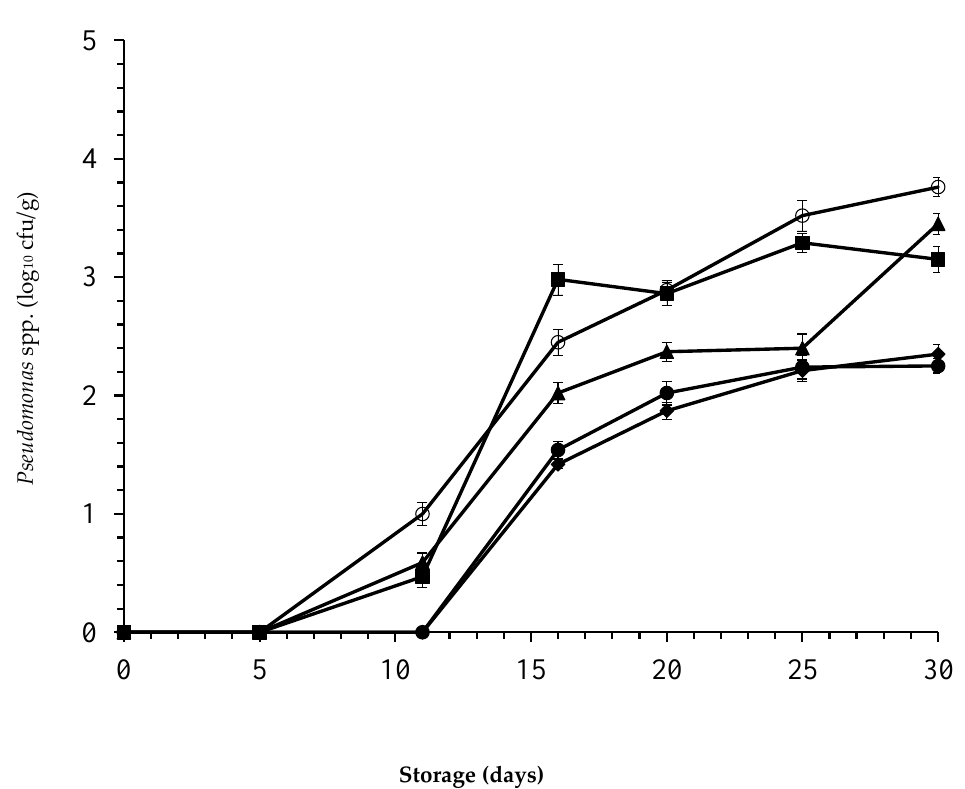
Figure 5. Numbers (log 10 cfu / g) of Pseudomonas spp. recovered from camel steaks stored at 1 ± 1 ◦ C under atmospheres of 80% O 2 and 20% CO 2 after treatment with 25 ppm nisin ( (cid:4) ); 500 ppm laper .OLE ( (cid:78) ); 25 ppm nisin / 500 ppm laper .OLE ( • ); 25 ppm nisin / 1000 ppm laper .OLE ( (cid:117) ); or untreated samples ( ). Error bars represent the standard deviation.